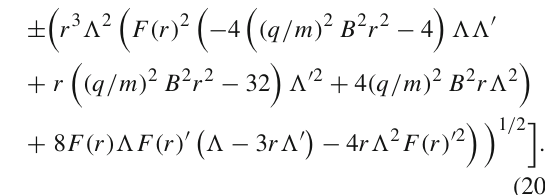
lar momentum L = 3 (left panel), L = 4 (middle panel) and L = 6 (right panel) for all possible orbits. Note that the particle starts from r 0 / M = 10 towards the black